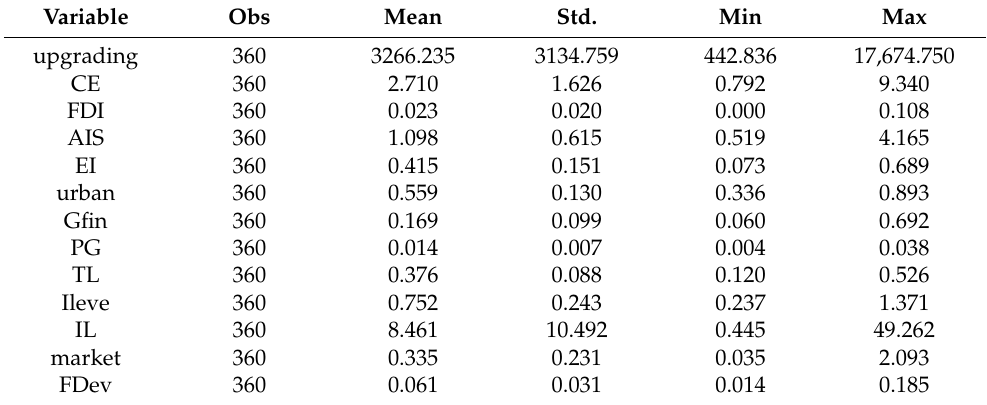
Table 2. Descriptive analysis.